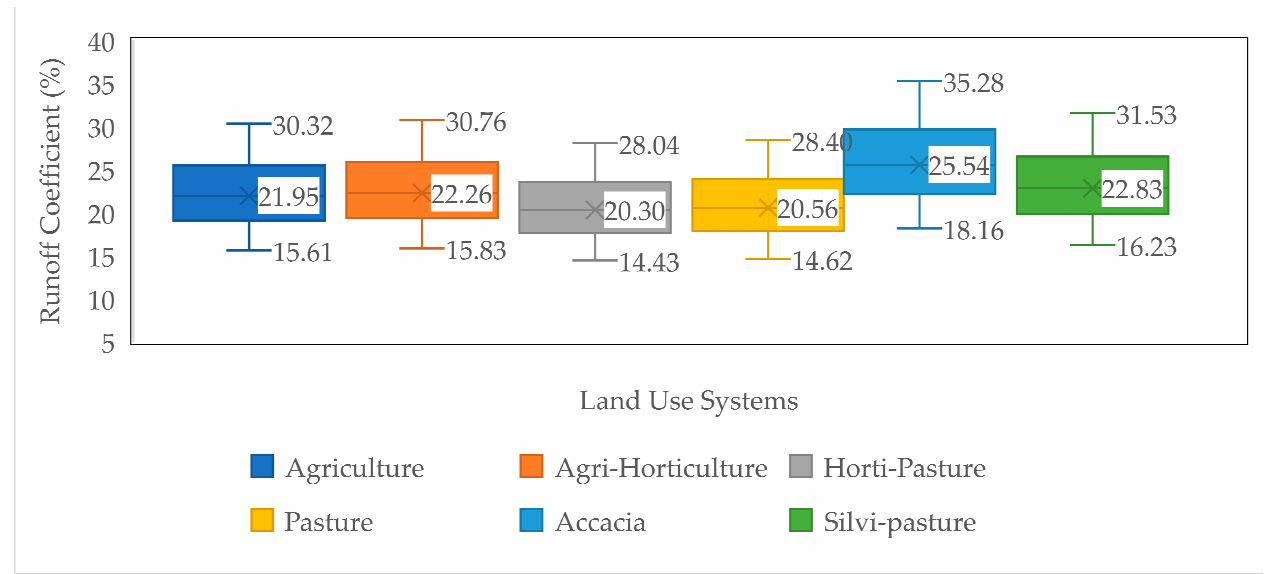
Figure 10. Average runoff coefficient (%) of selected land use systems in the marginal lands of Chambal riparian zone of India over the period of nine years of experiment (2011–2019). T 1 —Agriculture, Glycin max .; T 2 —Agri-Horti, Manilkara achras and Glycin max ; T 3 —Horti-Pasture, Emblica officinalis and Cenchrus ciliaris ; T 4 —Pasture, Cenchrus ciliaris ; T 5 —Silviculture, Accacia nilotica ; T 6 —Silvipasture, Accacia nilotica and Cenchrus ciliaris.